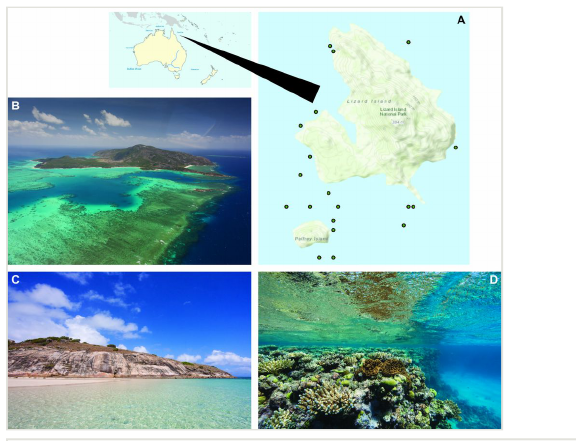
Lizard Island Group. A. Map of Lizard Island with collection sites for specimens examined in this study. B. Aerial photo view from the South. C. Typical coastal features of the island group. D. Typical reef edge near Lizard Island. (Photo credits Oliver